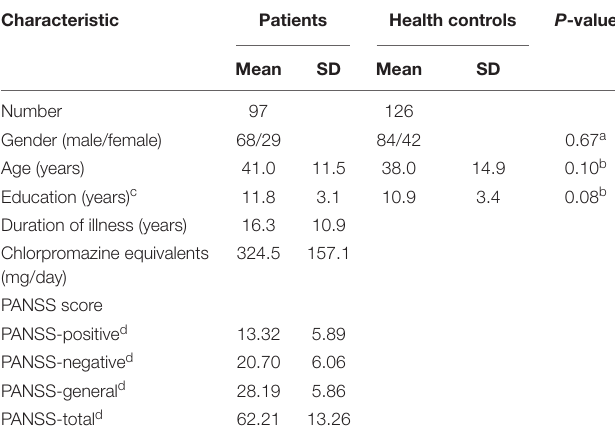
TABLE 1 | Demographic data for SZ vs. HC